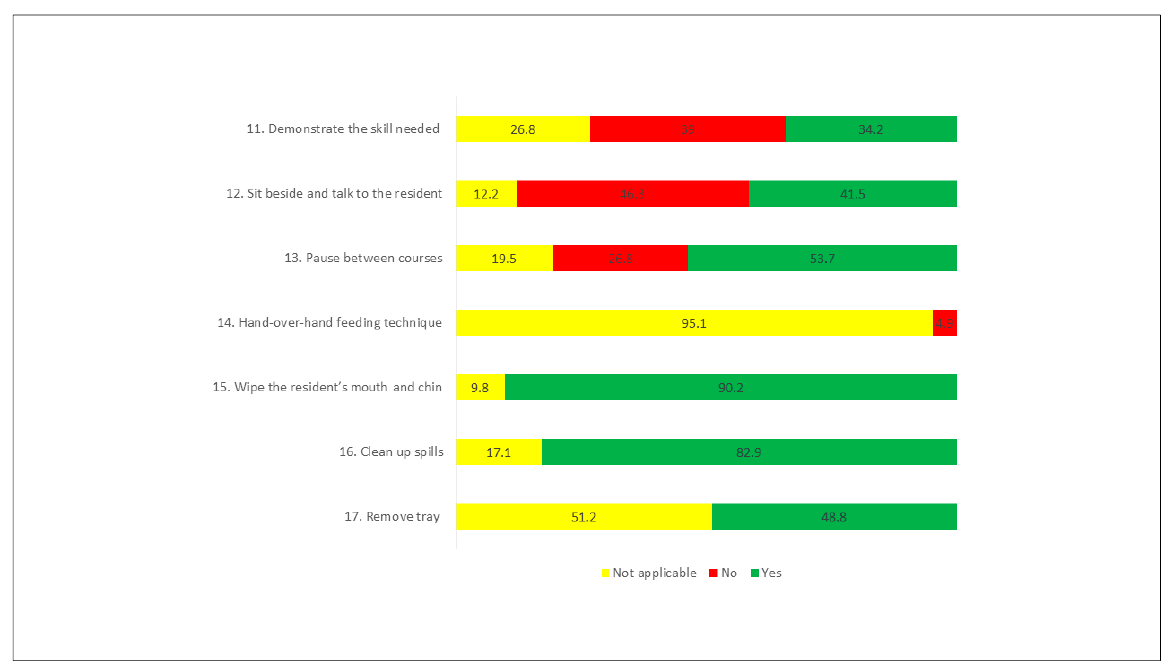
In the “caregiver” dimension, the most performed actions were items 15 (Wipe the resident’s mouth and chin, as needed during the meal), and 16 (Clean up any spills and change linen, as necessary) being performed, respectively, in 90.2% and 82.9% of the meals observed. The least performed action was item 11 (Demonstrate the skill needed), performed only 34.2% of the time (Figure 2).